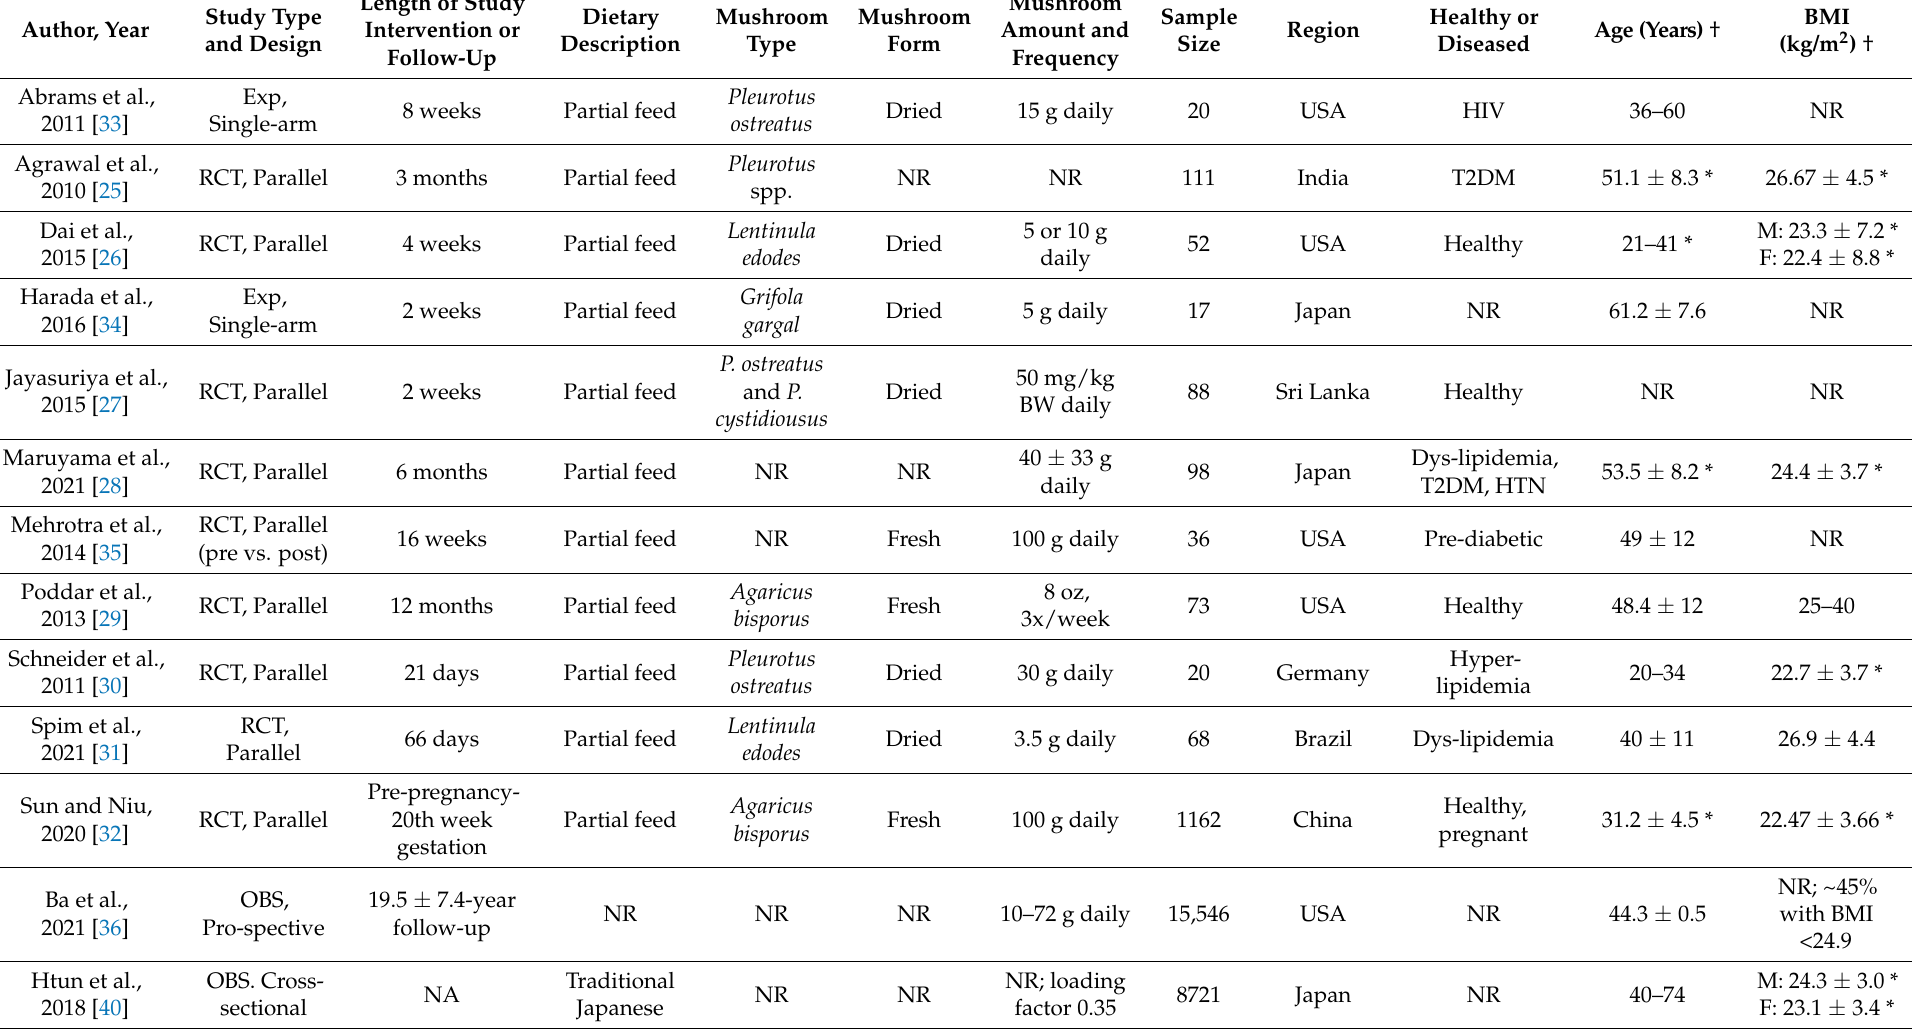
Table 3. Description of study